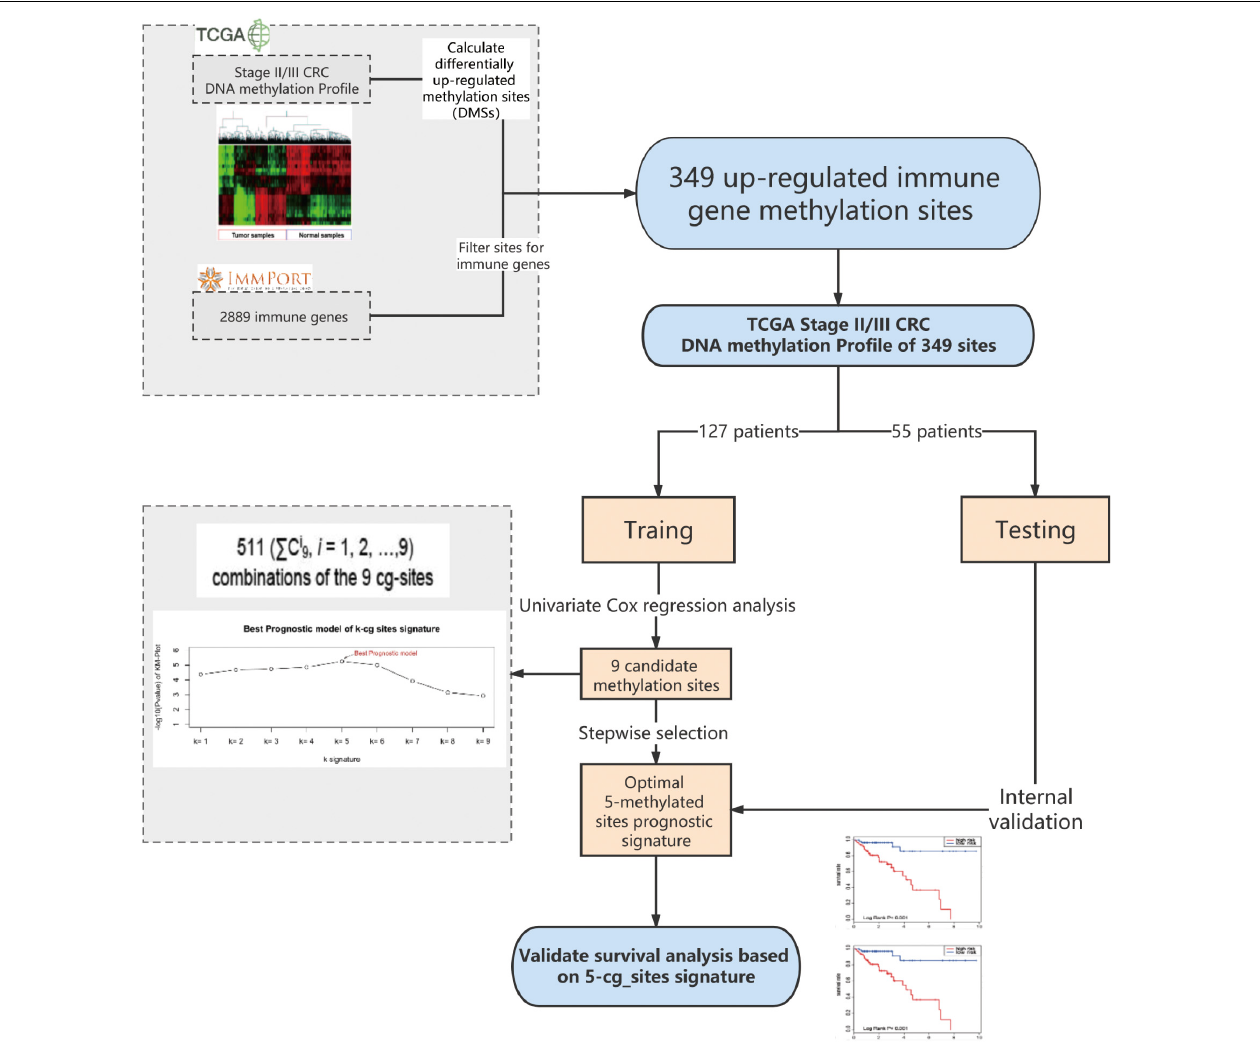
FIGURE 1 | I Dentification of the methylated signature in the training set. Methylated site profiling in tumor and normal tissue samples. Overall, 349 methylated sites were overlapped between 6450 differentially methylated sites (DMSs) and 2483 immune genes. Correlation between nine methylated sites and the survival of patients with stage II/III CRC in the training group was observed upon performing Univariate Cox regression analysis. Development of a prognostic classifier for all combinations of the nine CG sites using the CG Score. For each combination, patients were classified into high- and low-risk groups based on their median CG Score, and the five-methylated site signature with the largest value of − log(p) was selected as the final signature. DMSs, differentially upregulated methylation sites; CRC, colorectal cancer; TCGA, the cancer genome atlas; CG score, CG site-based risk